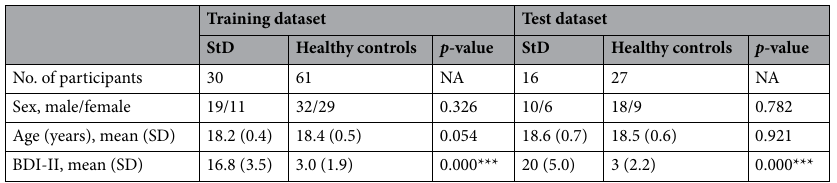
Table 1. Demographic and clinical information of the participants used to construct the subthreshold depression (StD) classifier. The differences between StD subjects and healthy controls were tested by a two- tailed t test (for age and BDI-II) or the chi-squared test (for sex). *** p < 0.001. BDI - II Beck’s Depression Inventory-II, NA not applicable, SD standard